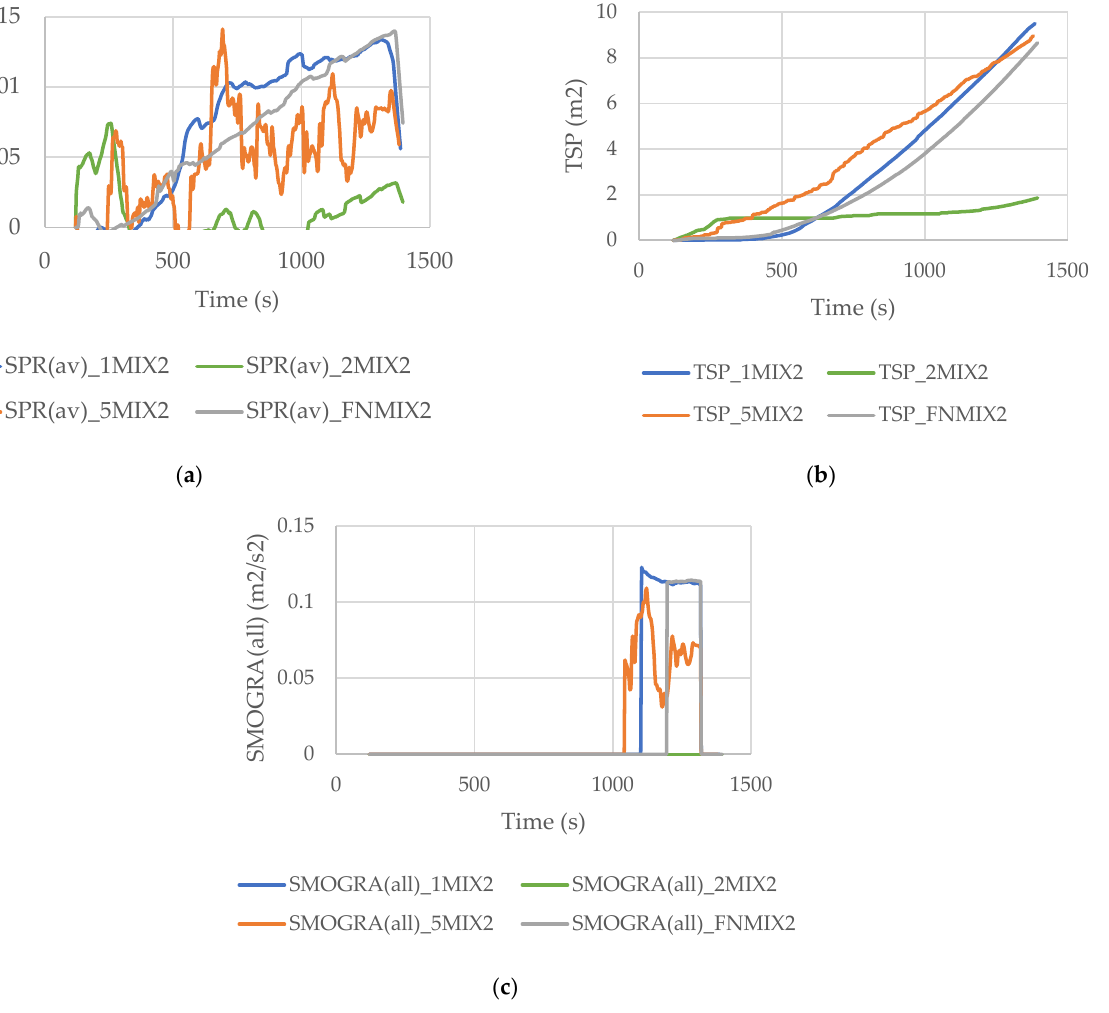
Figure 8. Test results from smoke production test to the coated samples (1MIX2, 2MIX2, 5MIX2, and FNMIX2) as specified by BS EN 13823 [13]: ( a ) Average of smoke production rate of the spec- imen (SPRav(t)); ( b ) Total smoke production of the specimen (TSP(t)); ( c ) Smoke growth rate of the